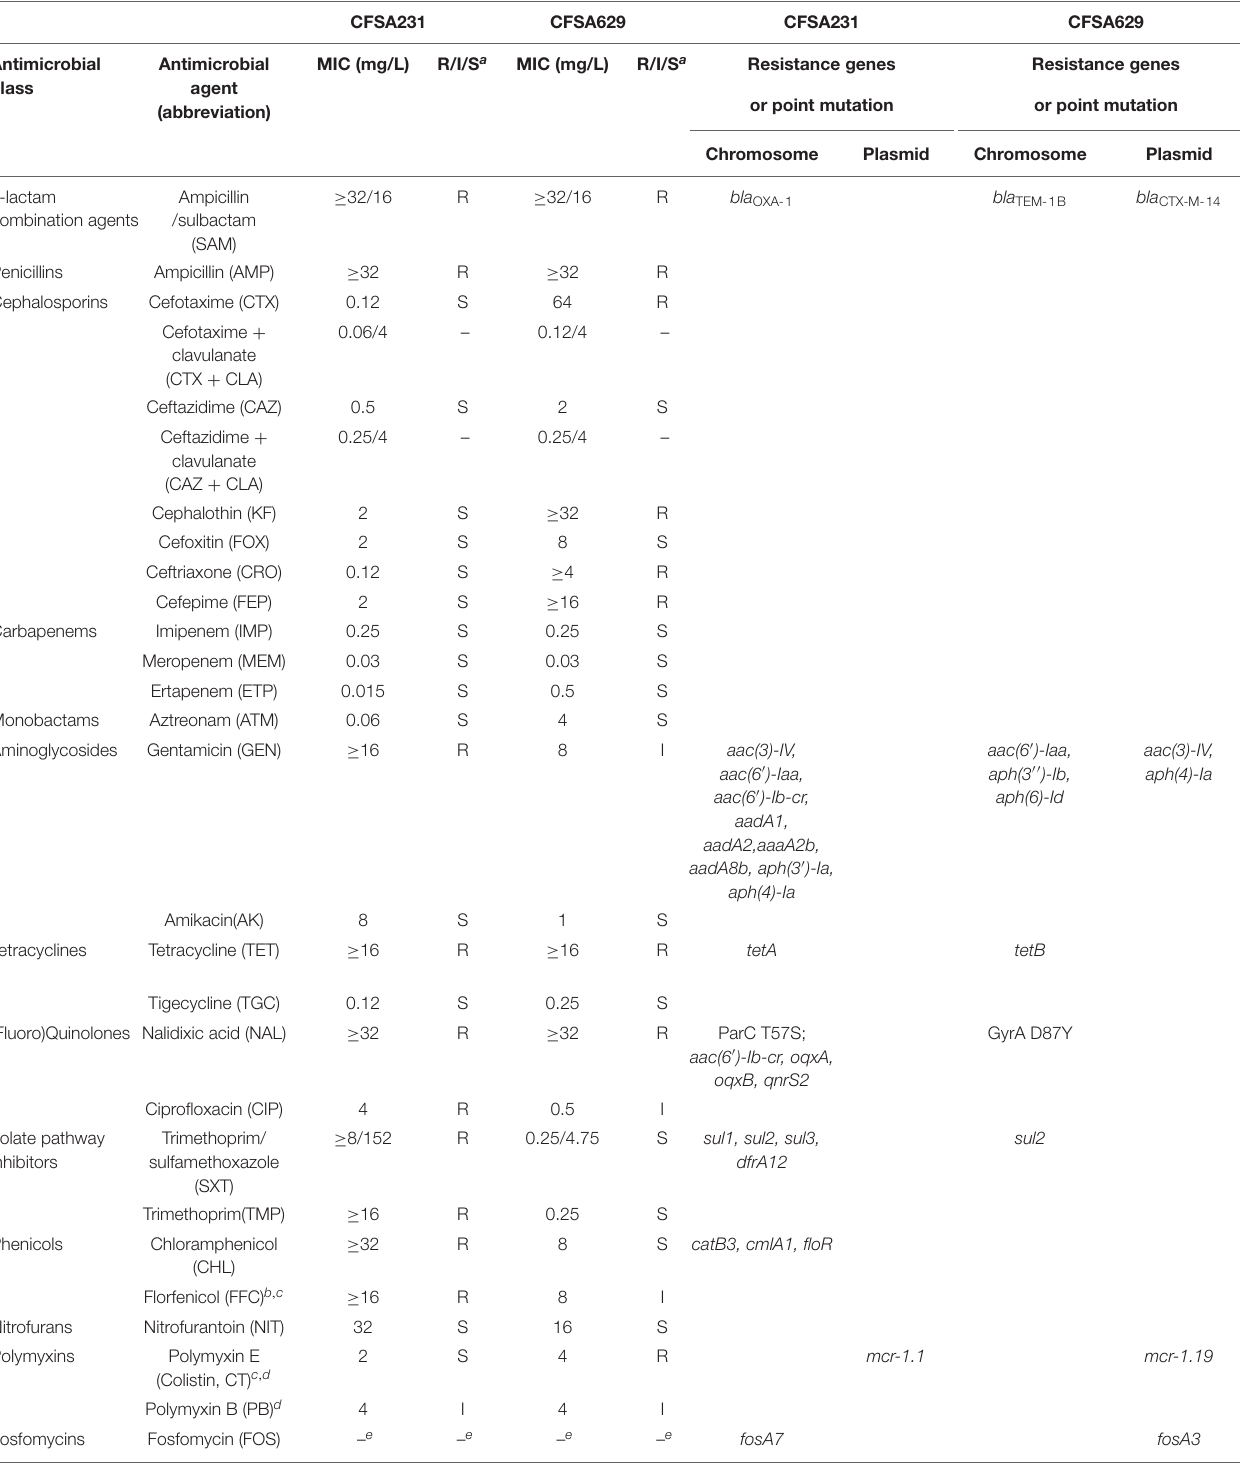
TABLE 2 | Antimicrobial susceptibility of Salmonella isolate CFSA231 and CFSA629 to a further panel of antimicrobial agents and acquired antimicrobial resistance-encoding genes identified in the bacterial genome with online retrieval in Resfinder database. CFSA231 CFSA629